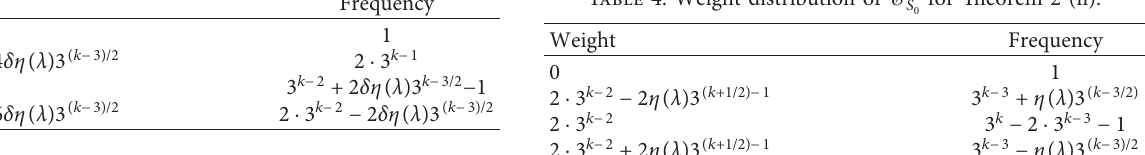
Table 4: Weight distribution of C